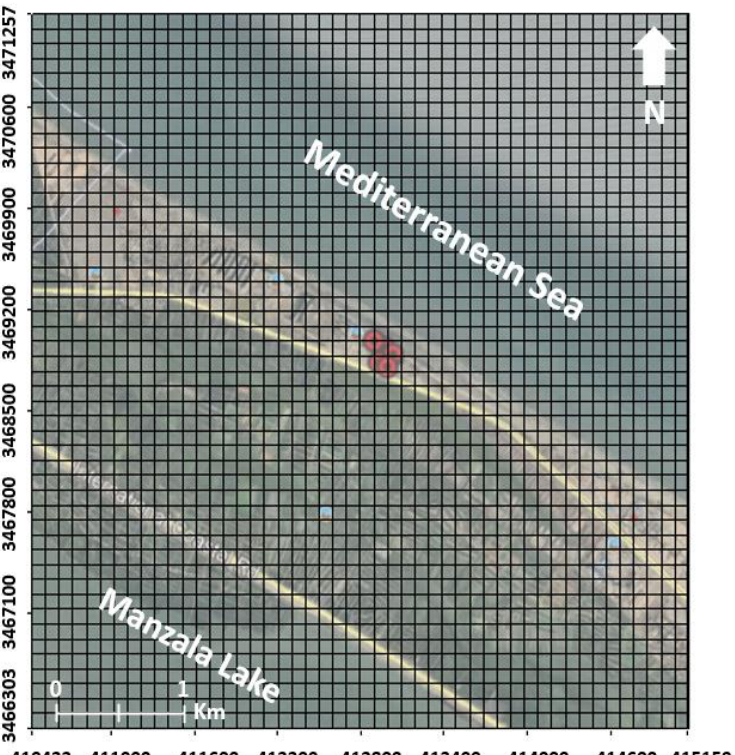
Figure 7. The grid cells for conceptual groundwater model .